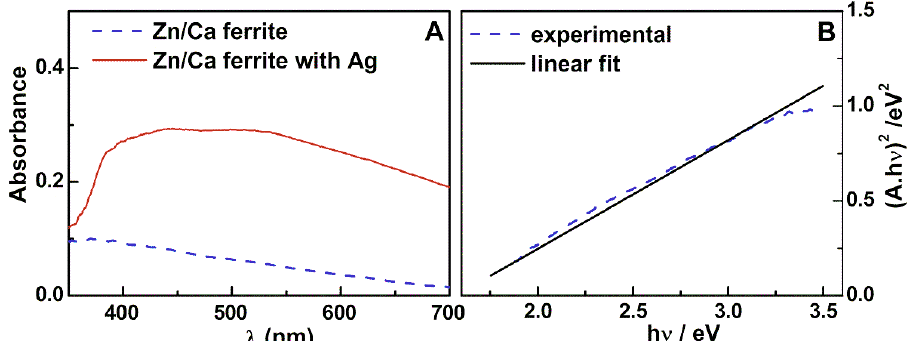
Figure 2. Absorption spectra of zinc/calcium ferrite obtained by the sol–gel method dispersed in water and with photode- posited silver ( A ) and Tauc plot for the ferrite nanoparticles ( B ).